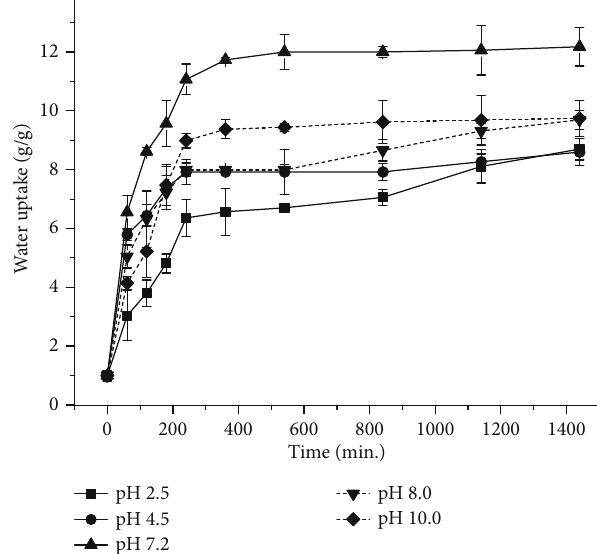
Figure 4: E ff ect of acidic (pH2.5 and 4.5) neutral (pH7.2) and saline (pH8.0 and 10.0) solutions on the water uptake of hydrogel H5 (g/g dry weight) after 24h of